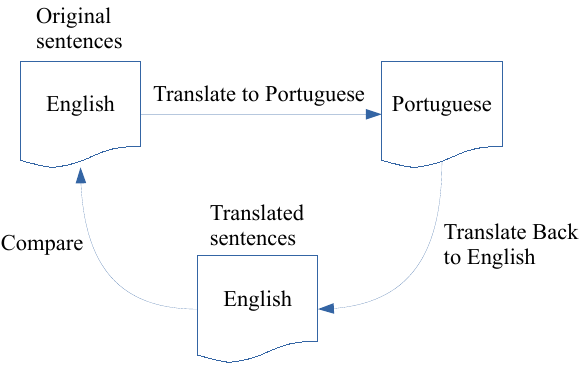
Figure 1. Back-Translation approach.